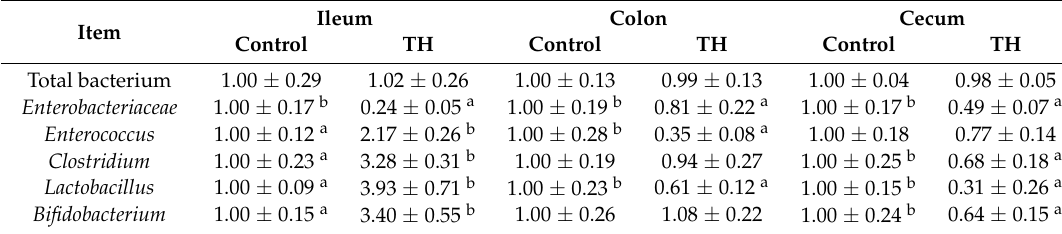
Table 6. Intestinal microflora of piglets.